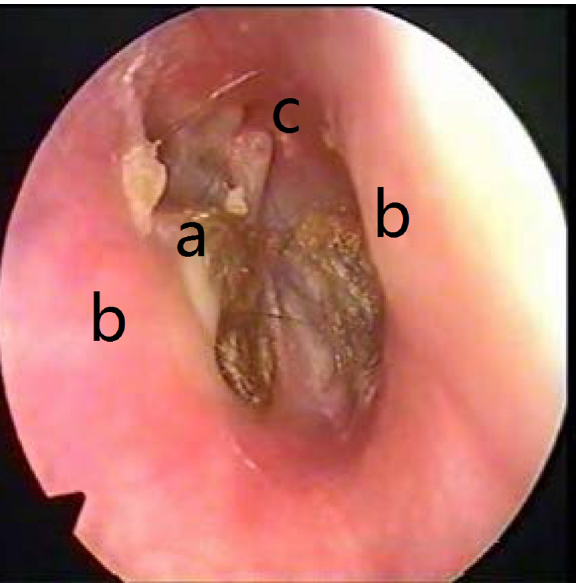
Fig 1. Preoperative transcanal microscopic view: (a) Cholesteatoma debris; (b) External auditory; canal bulging (obscures some part of the visual field); (c) Malleus.